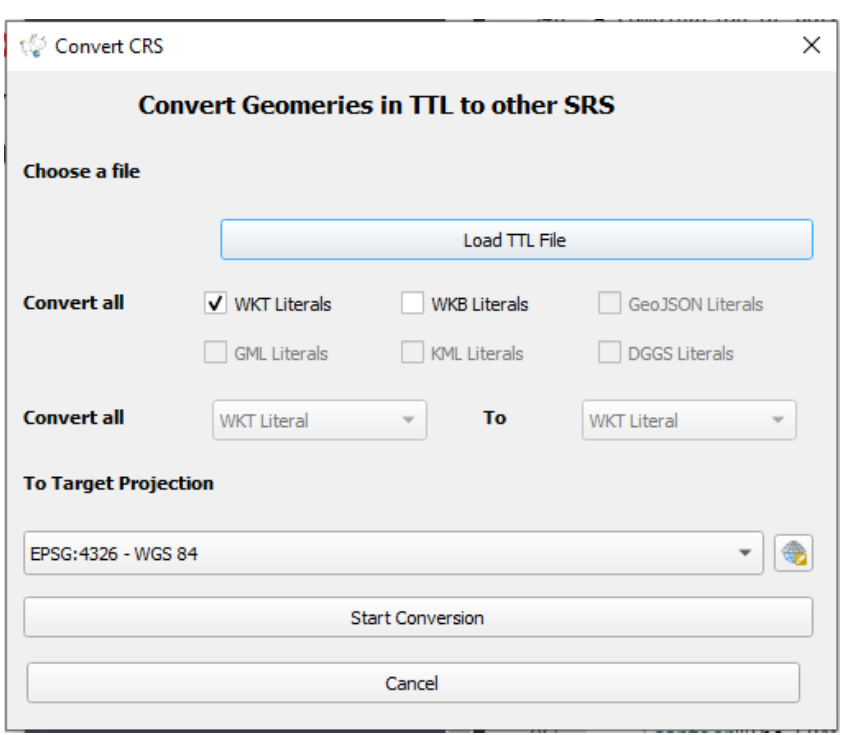
Figure 8. In-development conversion dialogue for geospatial Linked Data files aiming at full GeoSPARQL 1.1 literal conversion